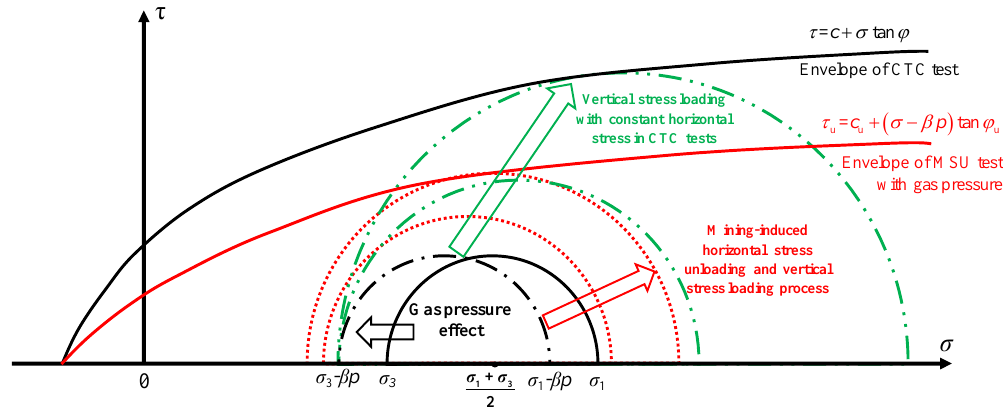
Figure 14. The mechanism of mining-induced stress unloading and gas pressure on coal strength.